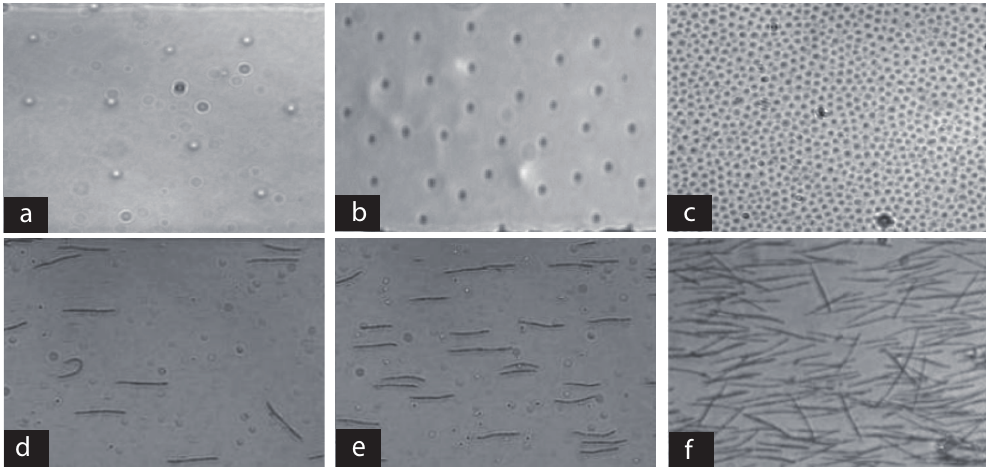
Figure 9. Variations of fiber concentration with the initial volume fraction of colloids in a given channel. ( a – c ) The fabrication phase in a 24 µ m-high channel for three different particle concentrations, leading to a large range of fiber concentrations ( d – f ). Note that the fibers are aligned with the imposed